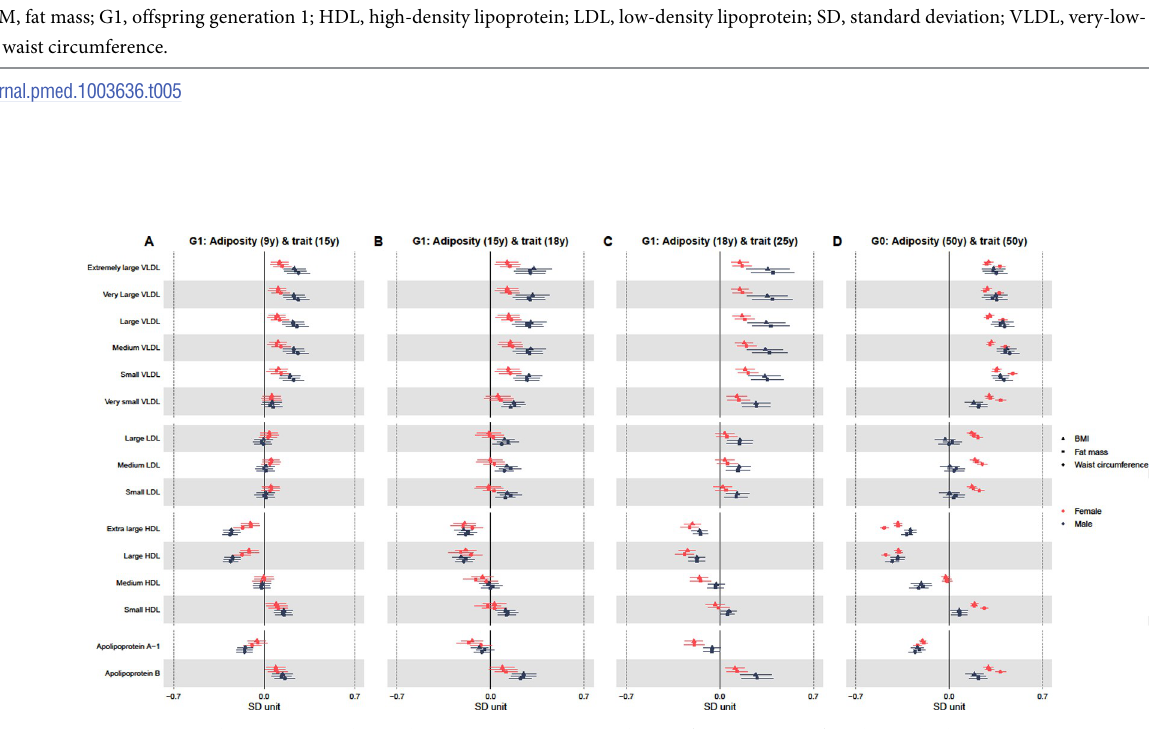
Fig 2. Sex-specific association of BMI, fat mass, and waist circumference (per SD increase) with standardised lipoprotein concentrations from childhood to midlife. Results shown are standardised differences with whiskers representing 95% CIs. These represent the standardised difference in cardiometabolic trait per SD increase in BMI, fat mass, and waist circumference in each sex separately for associations of adiposity at 9 y and traits at 15 y (A) , adiposity at 15 y and traits at 18 y (B) , adiposity at 18 y and traits at 25 y (C) , and adiposity at 50 y and traits at 50 y (D) . G1 analyses are adjusted for age at clinic completion, ethnicity, child’s mother and father education, maternal smoking during pregnancy, birth weight, gestational age, maternal age, household social class, and height and height 2 . Analyses of outcomes at 18 y and 25 y are also additionally adjusted for G1 offspring smoking. G0 analyses are adjusted for age at clinic completion, ethnicity, education, smoking during G1 cohort pregnancy, own social class, and height and height 2 . SD unit of BMI = 2.7 kg/m 2 , 2.9 kg/m 2 , 3.8 kg/m 2 , and 4.8 kg/m 2 at 9 y, 15 y, 18 y, and 50 y, respectively. SD unit of fat mass = 5 kg, 7.8 kg, 9.8 kg, and 10.2 kg at 9 y, 15 y, 18 y, and 50 y, respectively. SD unit of waist circumference = 7.4 cm, 7.8 cm, and 13 cm at 9 y, 15 y,